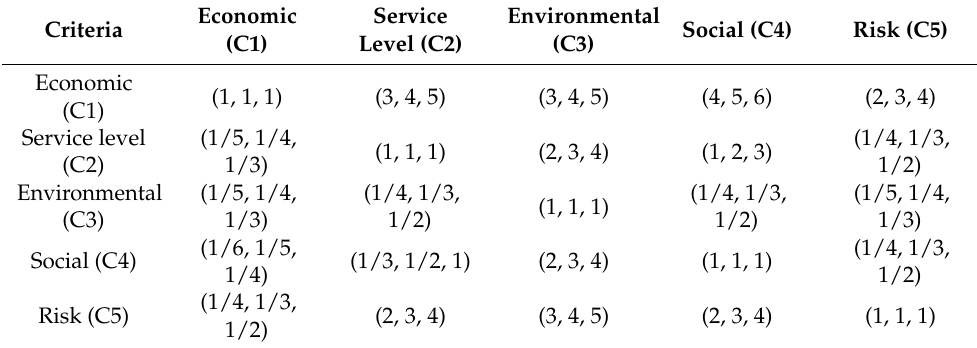
Table 6. The integrated fuzzy comparison matrix of FAHP model.